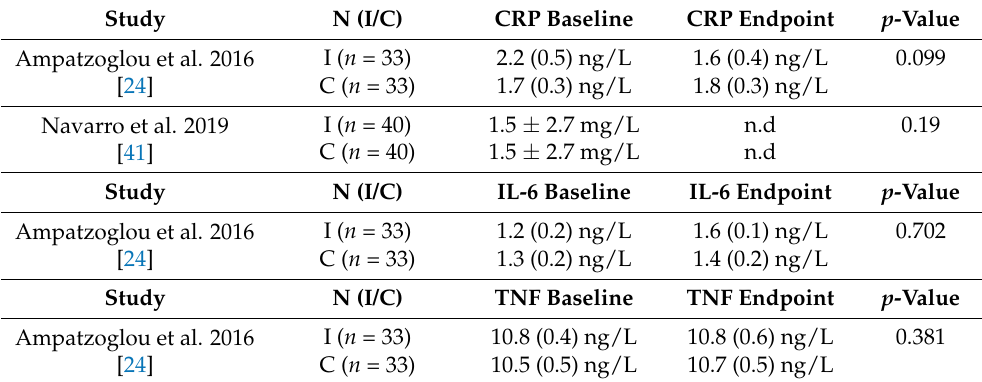
Table 2. Effect of whole grain consumption on inflammatory markers in healthy individuals between the intervention and control diet.